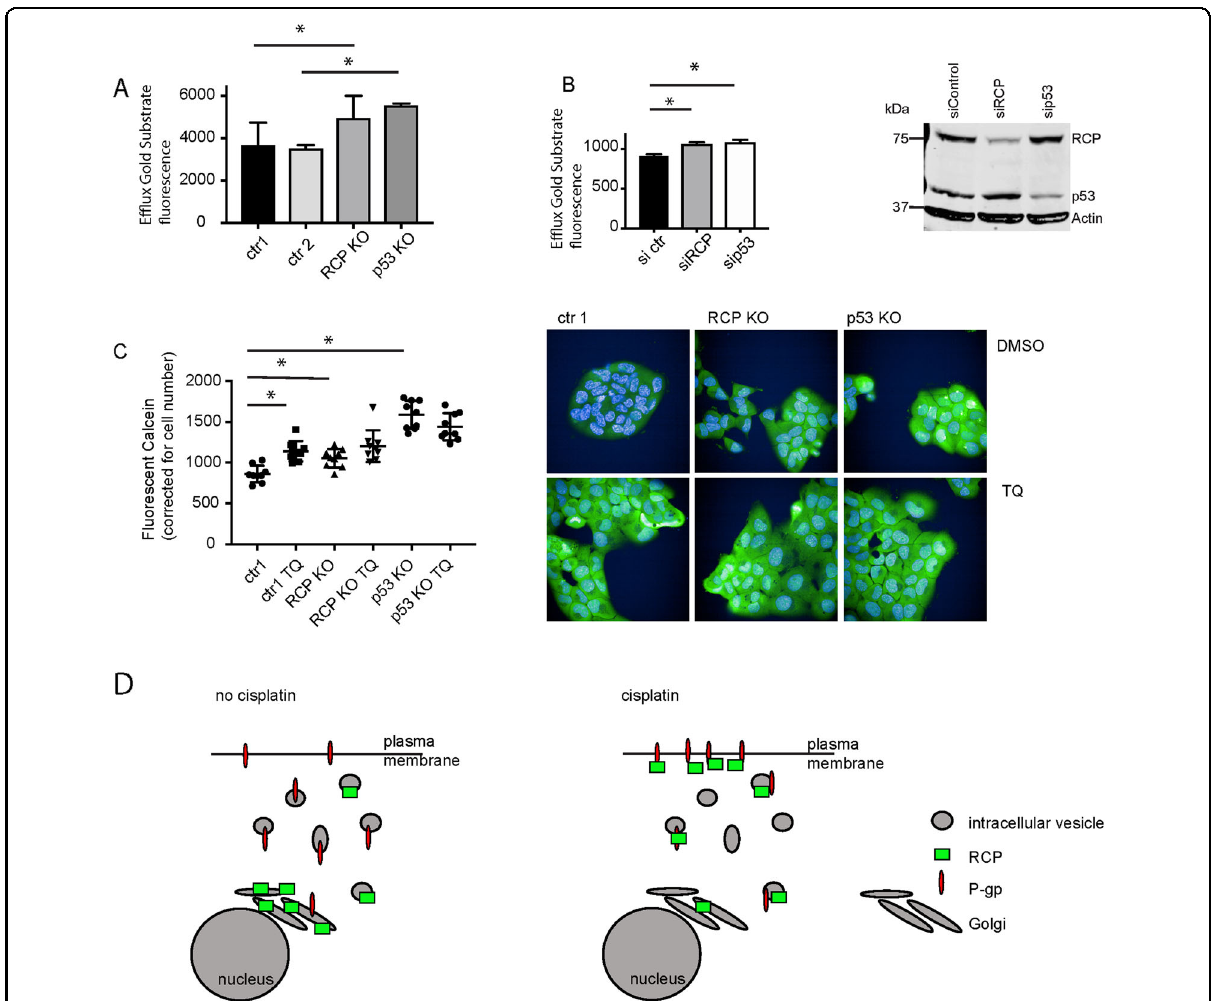
Fig. 6 Mutant p53 promotes drug ef fl ux by P-gp. A P-gp export function was determined by EFFLUX-ID Gold in A431 ctr1, ctr2, RCP KO and p53 KO cells. Statistical differences were measured using a paired t -test. ctr1 vs RCP KO, P = 0.0218, ctr2 vs p53 KO, P = 0.006, two-sided. Error bars indicate SD of three independent experiments. B HCT116 248W/- cells were transfected with 150 pmol of ctr siRNA, siRCP or sip53 for 48 h, followed by EFLUXX-ID Gold assay. Knockdown was con fi rmed using western blot to detect RCP and p53. Actin was used as loading control. Statistical differences were measured using a one-way ANOVA, sictr vs siRCP P = 0.0025, sictr vs sip53 P = 0.0009, two-sided. Error bars indicate SD of average values of three independent experiments. C Box and whiskers plot showing the calcein AM retention in A431 ctr1, RCP KO and p53 KO cells in response to 0.5 μ M Tariquidar (TQ). Individual values of three experiments (three technical repeats) are indicated with error bars representing SD. Statistical differences were measured using one-way ANOVA with multiple testing (two-sided). P -values are indicated in Supplemental Table 9 for all conditions. Example images of fl uorescent calcein are shown on the right. D Schematic model of RCP function in mutant p53 cells in response to cisplatin. In